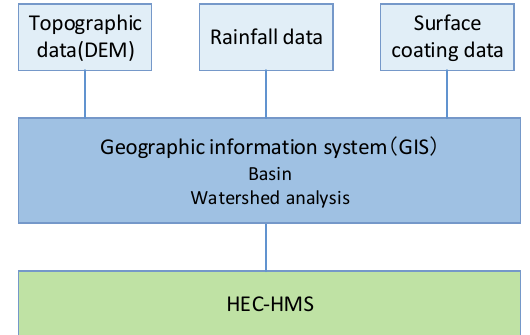
Figure 9. Flow of hydrologic analysis data